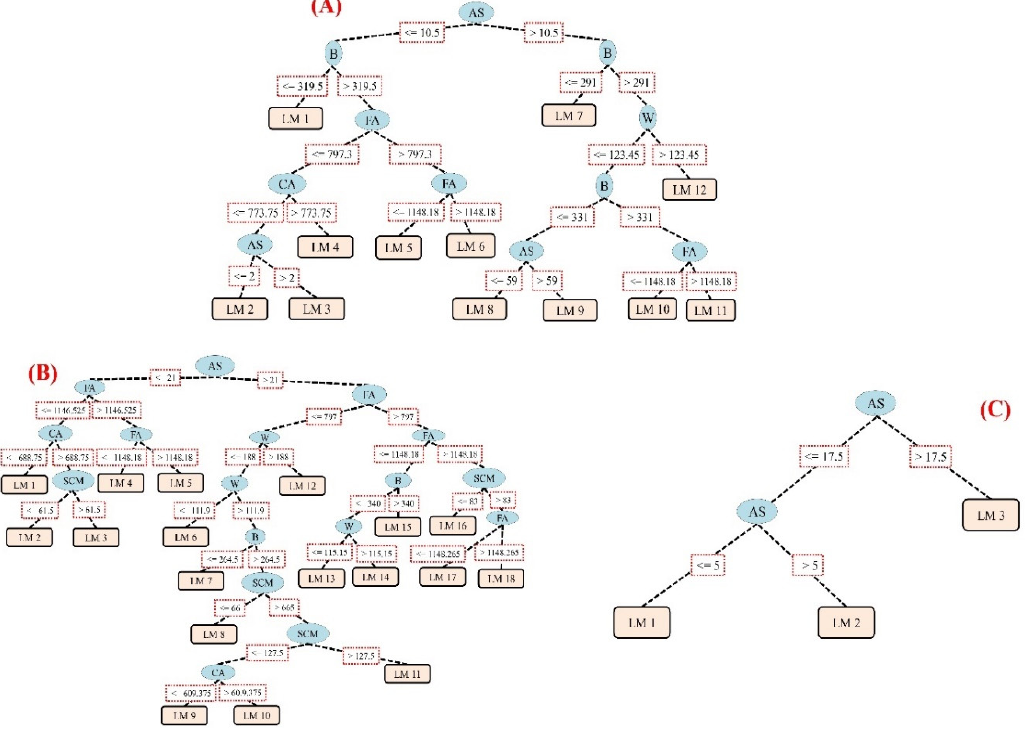
Figure 3. Tree diagram of the proposed M5p model; ( A ): CS, ( B ): TS, ( C ): FS.